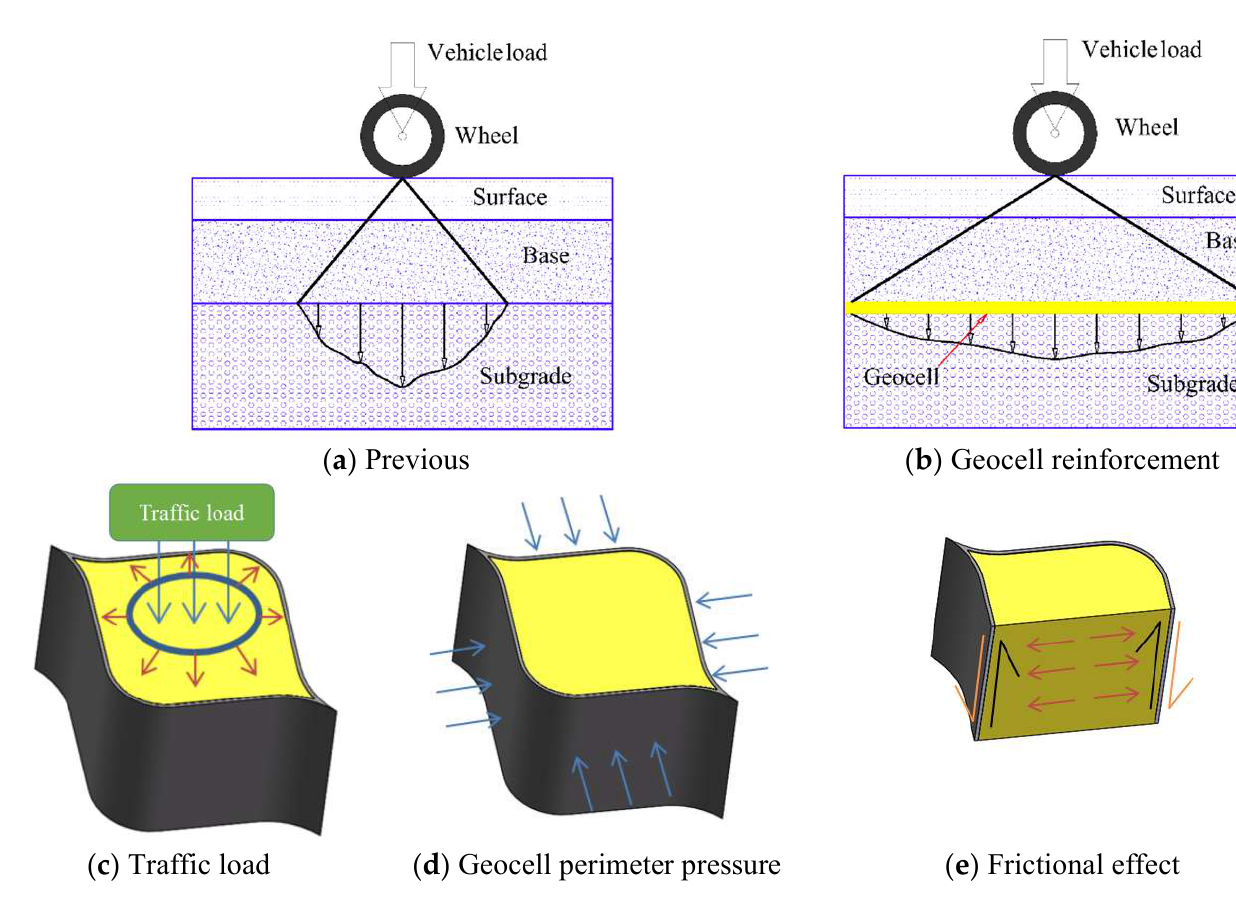
Figure 1. Geocell reinforcement mechanism diagram.